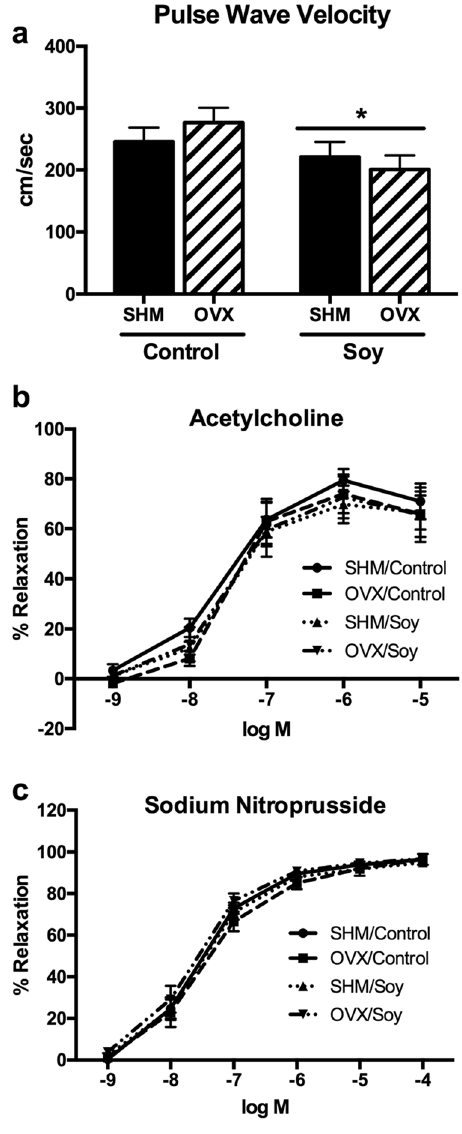
Figure 5. Aortic stiffness and vasomotor function in ovariectomized (OVX) vs. sham-operated (SHM) rats bred for low-running capacity fed either a soy-rich or soy-free diet. ( a ) aortic pulse wave velocity; ( b ) acetylcholine-induced relaxation in aortic rings; ( c ) sodium nitroprusside-induced relaxation in aortic rings. Data were analyzed using the Mixed Models procedure of SAS 9.3 with diet and surgery being fixed